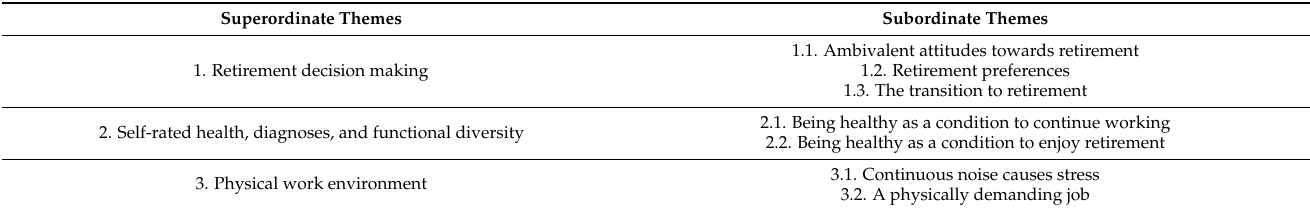
Table 1. Thematic